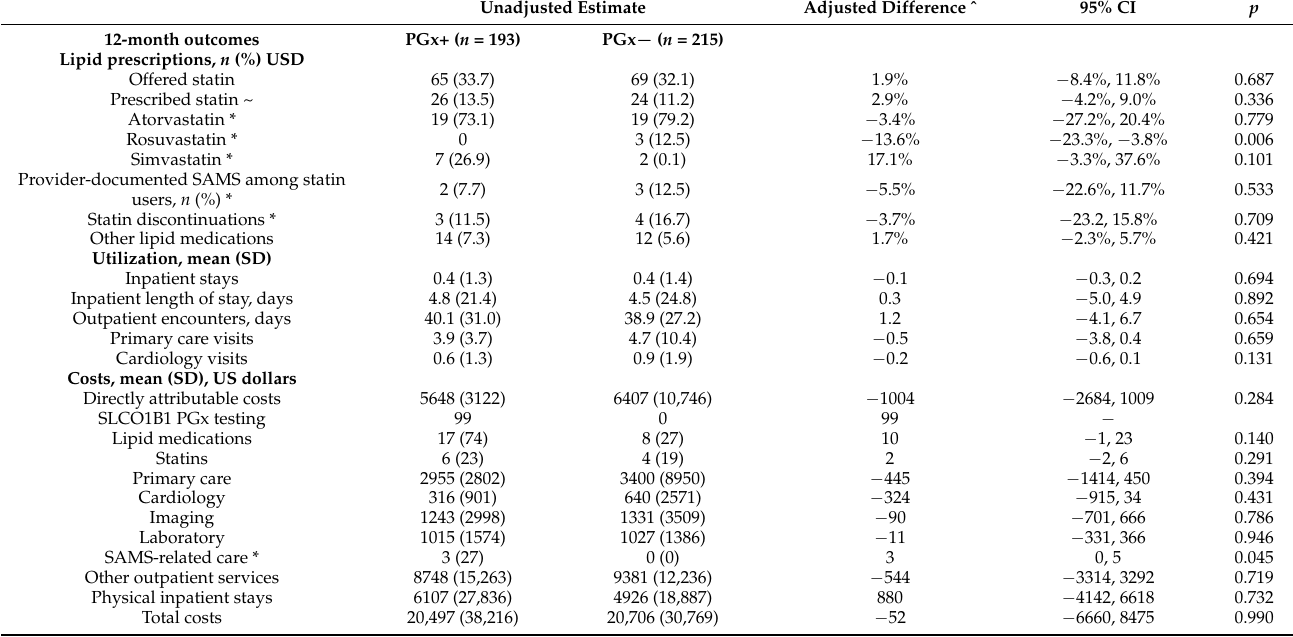
Table 2. Costs and consequences among I-PICC study participants over the 12-month trial